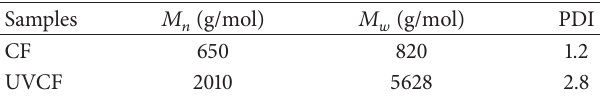
Table 2: Molecular weight and molecular weight distribution of CF resin and UVCF